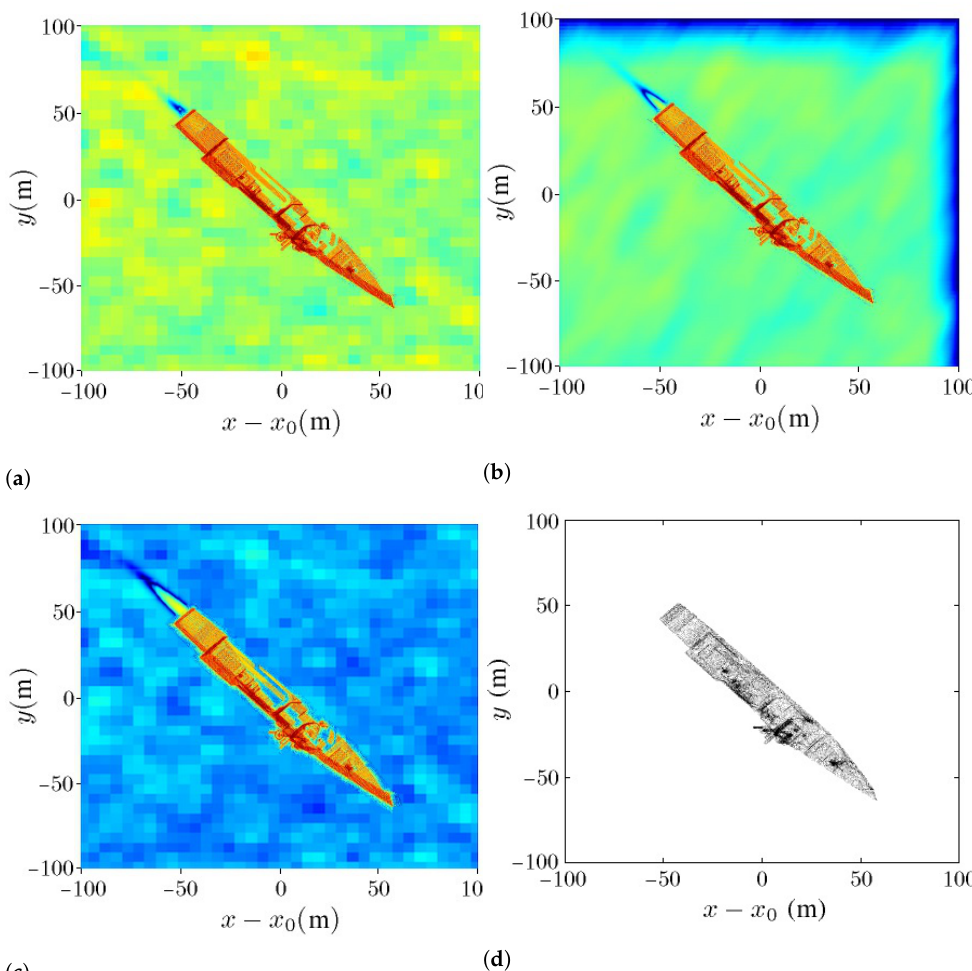
Figure 12. Acquired images of Arleigh Burke-class destroyer, in scale of (40, 90) dB, ( a ) ship, wake and sea surface are static, ( b ) ship, wake and sea surface are moving, ( c ) ship and wake are moving, sea surface is static, and ( d ) scan image of 3D